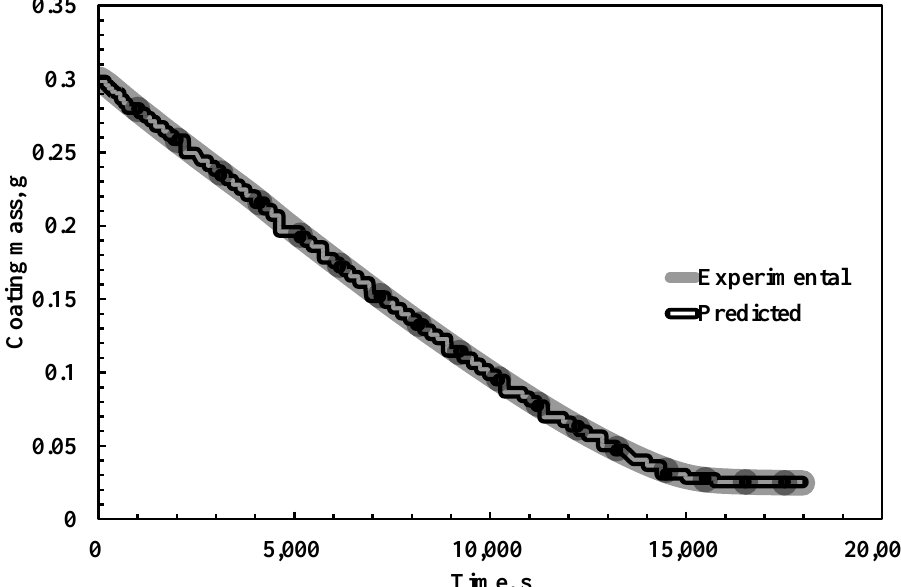
Figure 7. Comparison of model prediction with the experimental values for coating having 2009 micron initial coating thickness having poly(styrene), p -xylene, and TPP, 4.99%, 93.01%, and 2.00%